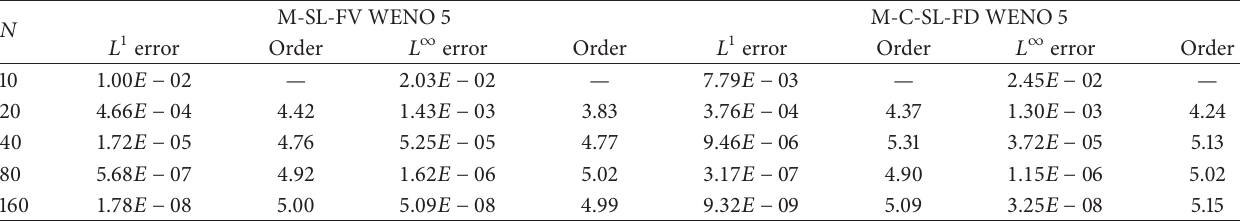
Table 1: Left: M-SL-FV WENO 5 scheme, right: M-C-SL-FD WENO 5 scheme for Example 1 on a uniform mesh of 𝑁 cells at 𝑡 = 0.5 , CFL = 5.9, and 𝜀 = 10 −40 .